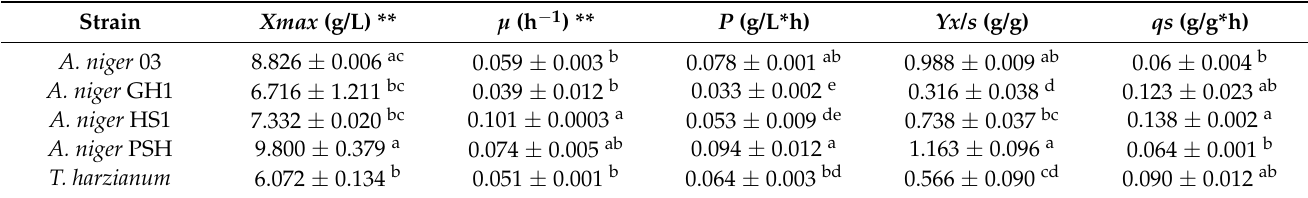
Table 2. Estimation of experimental and calculated; fermentation kinetic